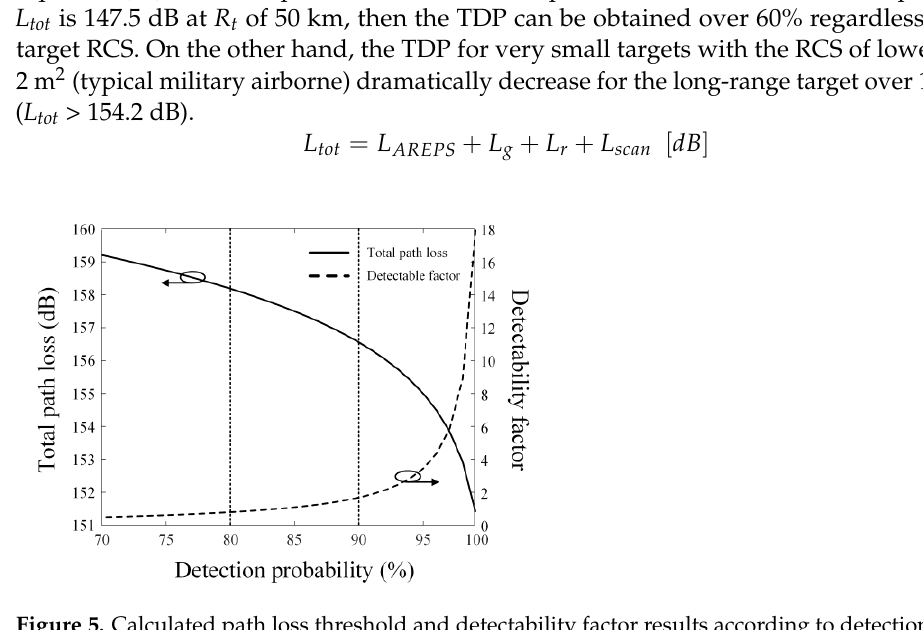
Figure 5. Calculated path loss threshold and detectability factor results according to detection prob- ability.